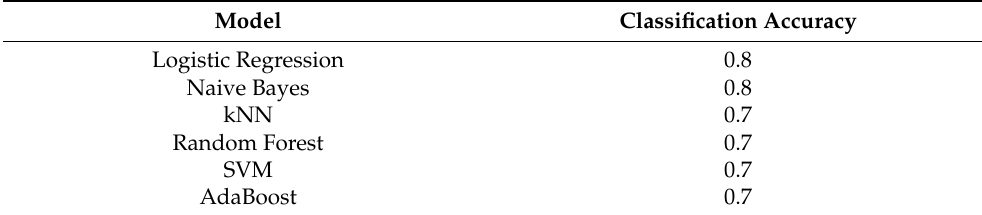
Table 4. Model comparison by classification